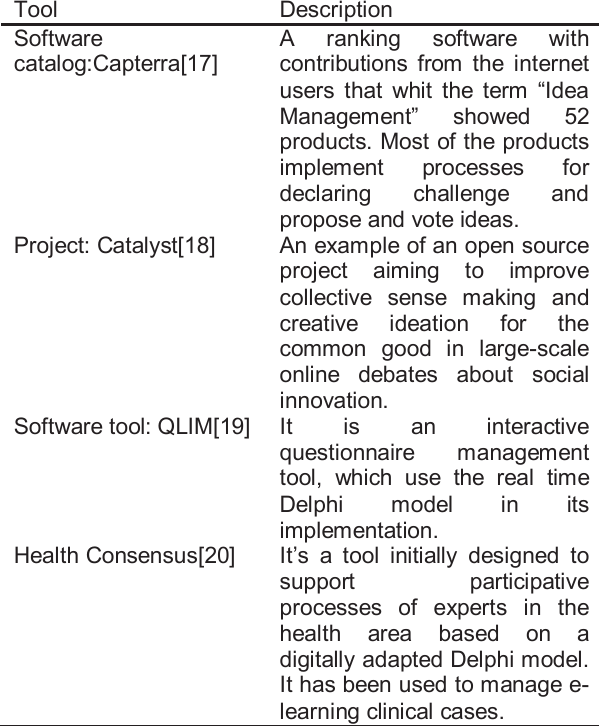
Table 1. Sumary of Collective Intelligence Internet